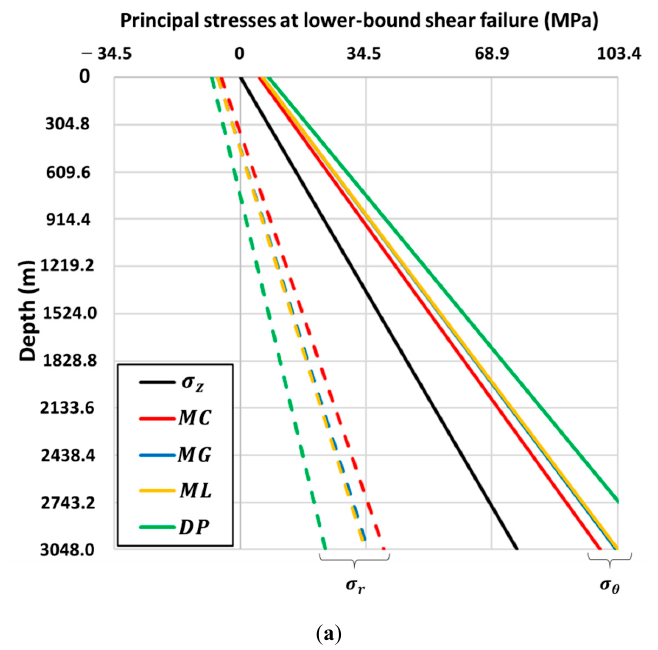
Figure 7. Normal faulting regime. Locally induced principal stresses at a moment of ( a ) lower-bound and ( b ) upper-bound shear failure under the normal faulting regime with the vertical, maximum and minimum horizontal stresses of 22.6, 20.4, and 15.8 kPa / m, respectively. The black solid lines represent the axial stress ( σ z ) . The tangential ( σ θ ; solid) and radial ( σ r ; dashed) stresses are calculated by the Mohr–Coulomb (MC; red), Mogi–Coulomb (MG; blue), modified Lade (ML; yellow), and Drucker–Prager (DP; green) failure criteria. The magnified frame in (b) indicate reverse of the principal stress order. ( c ) Critical wellbore pressure di ff erence at upper-bound shear failure. Di ff erence between the Mohr–Coulomb (MC) and Mogi–Coulomb (MG), and the Mogi–Coulomb and modified Lade (ML) are shown in red and yellow curves, respectively. At 1147 m, the red curve reaches 0 and the yellow curve shows the maximum